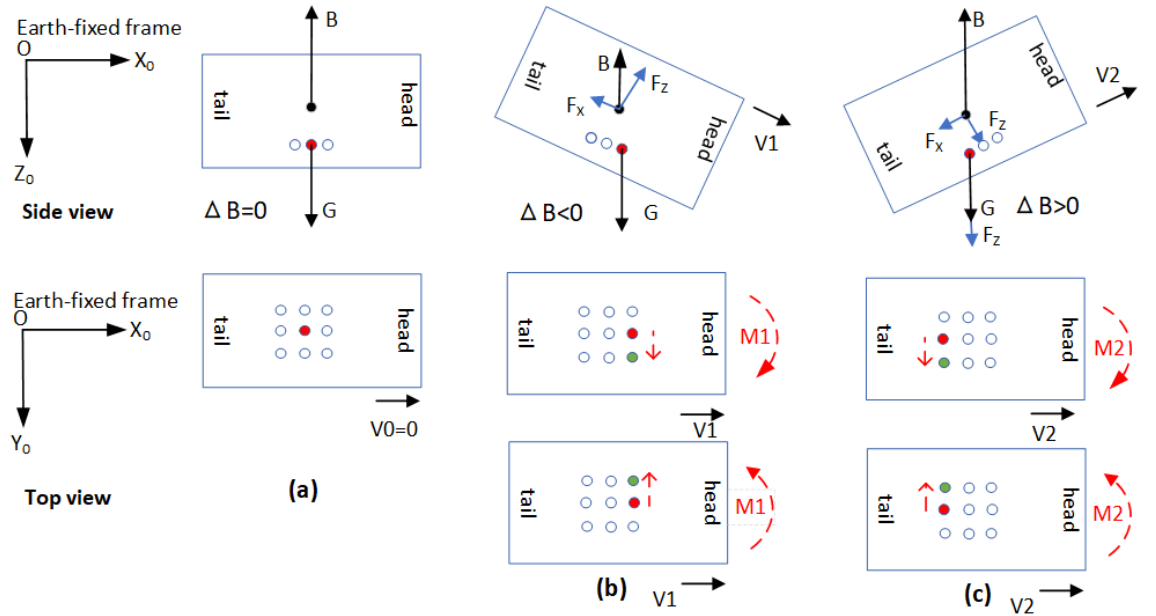
Figure 4. The force analysis diagram of the robot gliding up and down. In the charts, the red dots indicate the locations of the centroid, the black dots represent the locations of the center of buoyancy, and the white dots denote the possible locations of the centroid. The red dotted lines indicate that if the centroids move from the red dots to the green ones, the red curve moments will form. ( a ) Force analysis diagram of the robot when it is stationary. ( b ) Force analysis diagram of the robot when it is gliding down. ( c ) Force analysis diagram of the robot when it is gliding up.